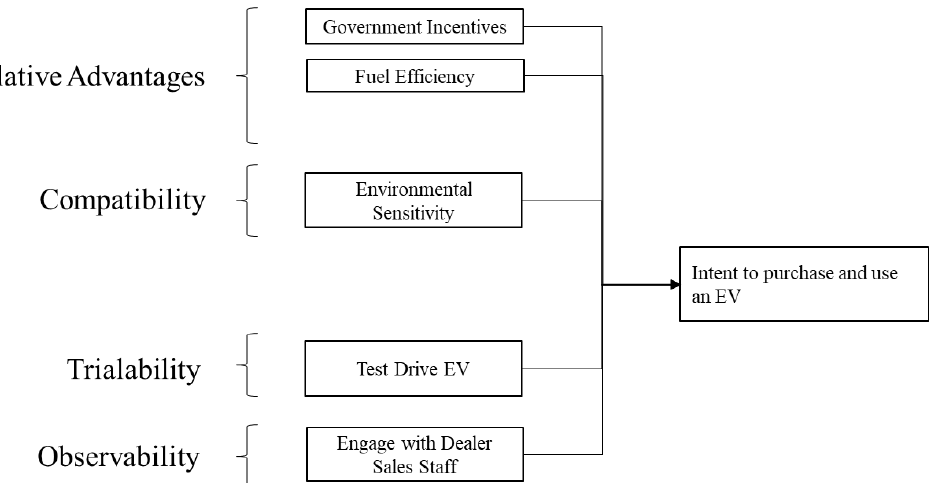
Figure 3. Revised model for adoption of EVs in Ontario,